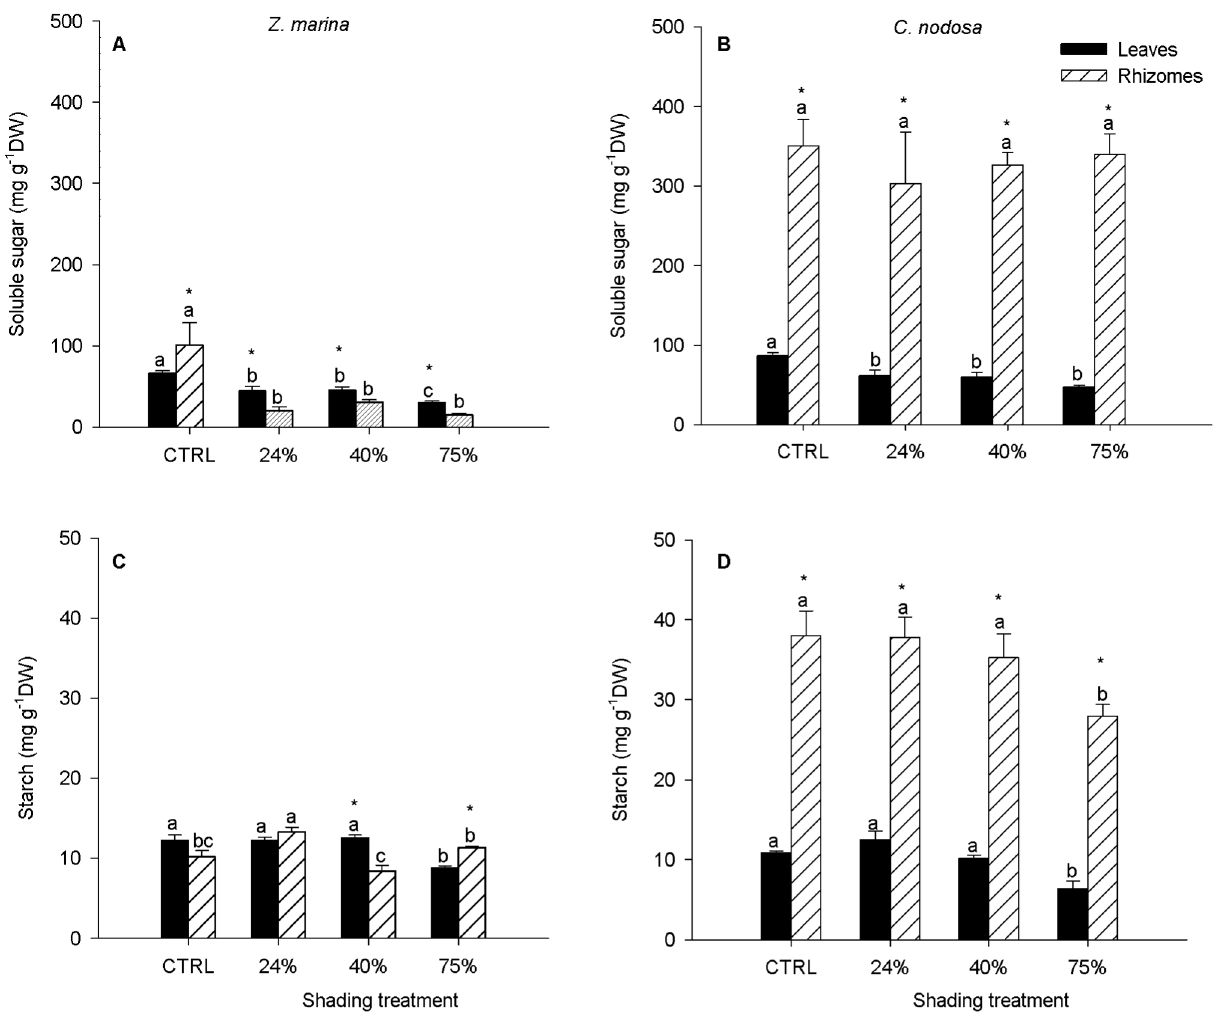
Figure 5. Soluble sugars (A and B) and starch (C and D) content in leaves and rhizomes of Zosteramarina (A, C) and Cymodocea nodosa (B, D). Plants submitted to shading treatments of 24, 40 and 75% of naturally available photosynthetically active radiation (CTRL). Different letters indicate significant differences between treatments, * indicates differences between leaves and rhizomes (n=5, p , 0.05).